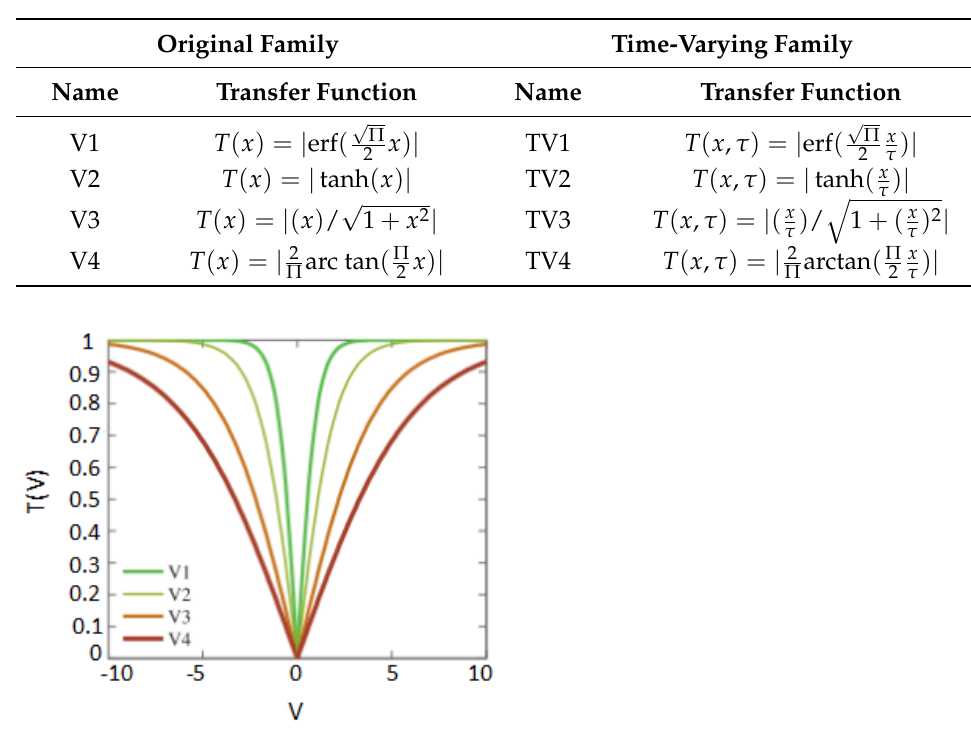
Figure 2. V-shaped transfer